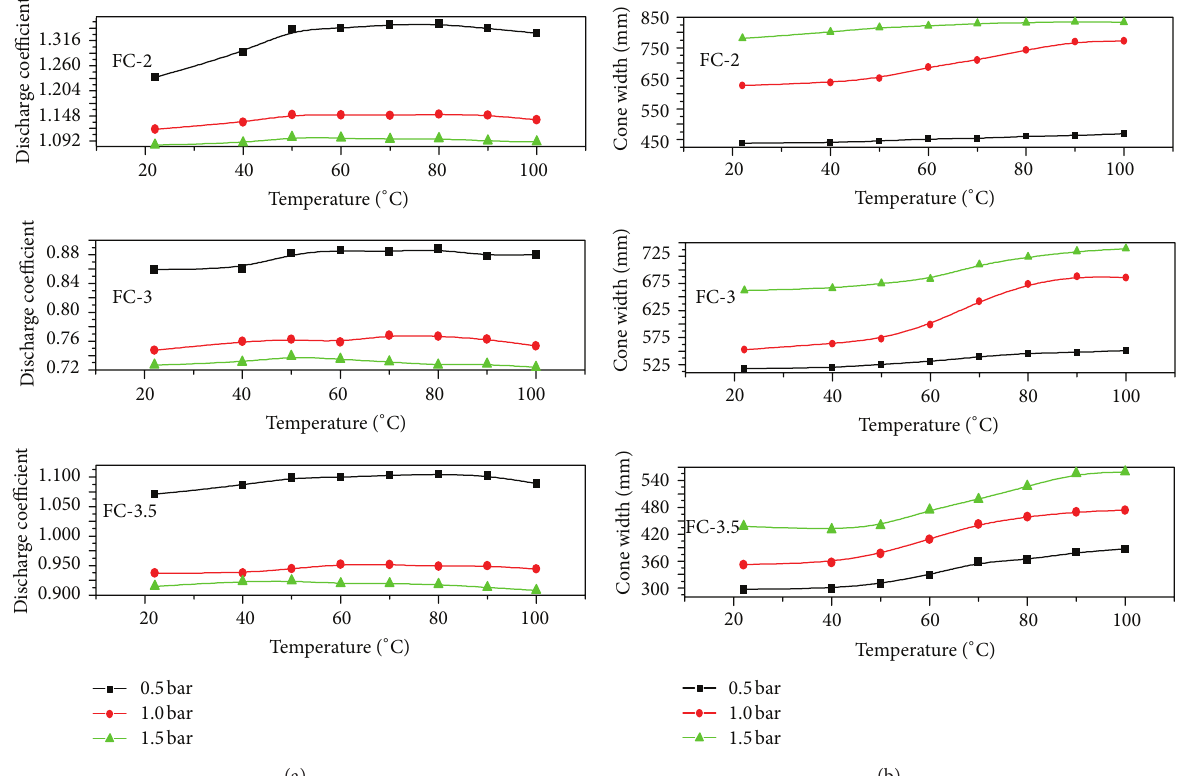
Figure 3: (a) Discharge coefficient as a function of temperature, (b) Spray width as a function of